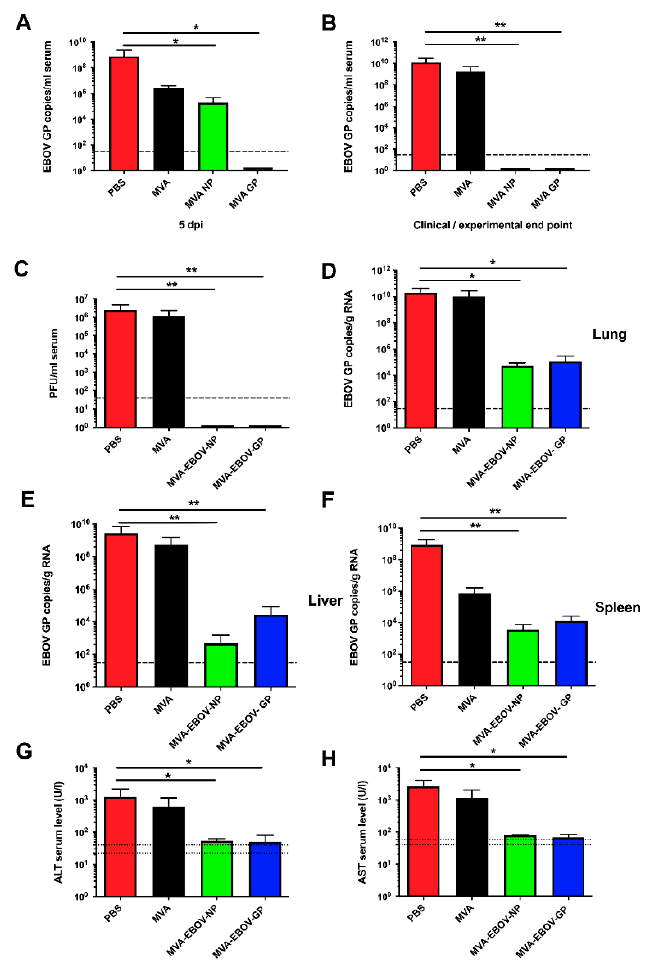
Figure 4. EBOV loads and clinical chemistry in infected mice. EBOV GP RNA copies in the sera at 5 dpi (days post infection) ( A ) or at the clinical (PBS, MVA: 7 or 8 dpi) or experimental (MVA-EBOV-NP, MVA-EBOV-GP: 14 dpi) end point ( B ). ( C ) Infectious EBOV in the sera at the clinical end point. EBOV GP RNA copies in lung ( D ), liver ( E ) and spleen ( F ) at the clinical end point; dashed lines: limit of detection; PBS, MVA-EBOV-GP, MVA-EBOV-NP: n = 5 mice, MVA: n = 3 mice. ( G ) ALT (alanine aminotransferase) and ( H ) AST (aspartate aminotransferase) levels at the clinical end point; dotted lines: physiological range. Error bars: standard deviation; PBS: n = 5, MVA: n = 4, MVA-EBOV-GP, MVA-EBOV-NP: n = 2 mice; * p < 0.05; ** p < 0.01 (one-tailed).